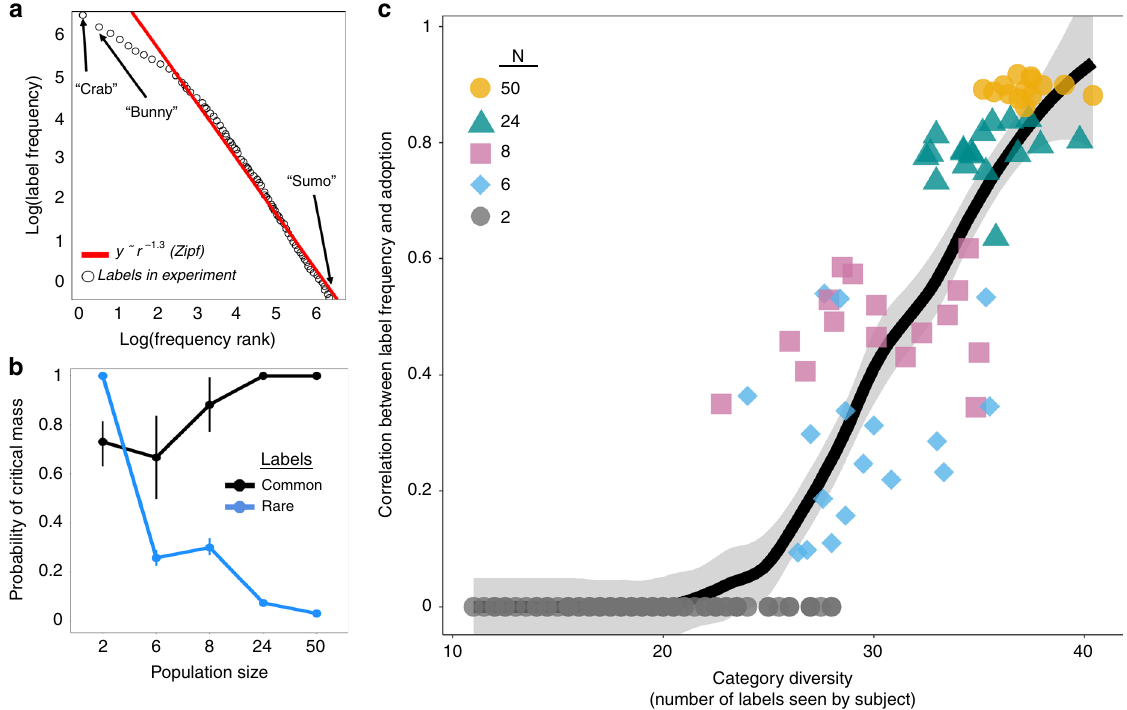
Fig. 3 Larger populations amplify the spread of initially frequent labels. a Using the Zipf distribution to model the initial frequency of labels (including data from all conditions; N = 2, N = 6, N = 8, N = 24, and N = 50), where initial frequency refers to the number of individuals who introduced a label without any prior exposure to the label in the task. Vertical axis displays the log of each label ’ s initial frequency. Horizontal axis displays the log of each label ’ s frequency rank. b Displaying the mean effect of population size on the ability for labels to reach critical mass (when at least 25% of subjects in a network independently introduce a label). Common labels are identi fi ed as outliers with high initial frequency (Supplementary Information section 1.3). Data display the proportion of experimental trials in each condition for which each label type reached critical mass. Error bars display 95% con fi dence intervals. c The correlation between the initial frequency of a label in a population and the proportion of subjects in a population who adopted the label (vertical axis), where adopting a label entails that a subject produced a label after being exposed to it. Horizontal axis displays the diversity of categories in each trial, indicated as the average number of unique labels encountered by each subject in a network. Error bands display 95% con fi dence intervals. All observations are independent and at the network-level. All panels represent data from 80 unique dyads and 15 unique social networks of each